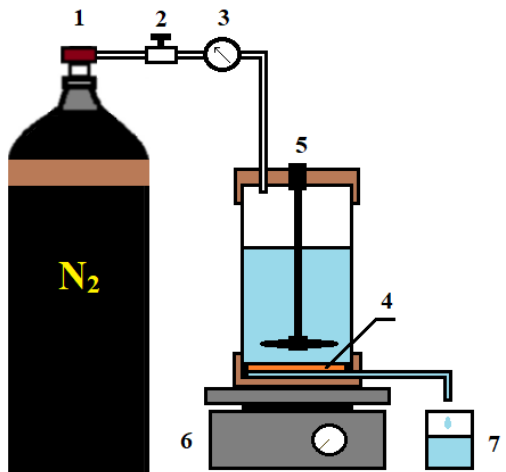
Figure 2. Ultrafiltration setup: 1—nitrogen tank, 2—pressure regulator, 3—manometer, 4—membrane, 5—stirred ultrafiltration cell, 6—magnetic stirrer, 7—container for permeate.